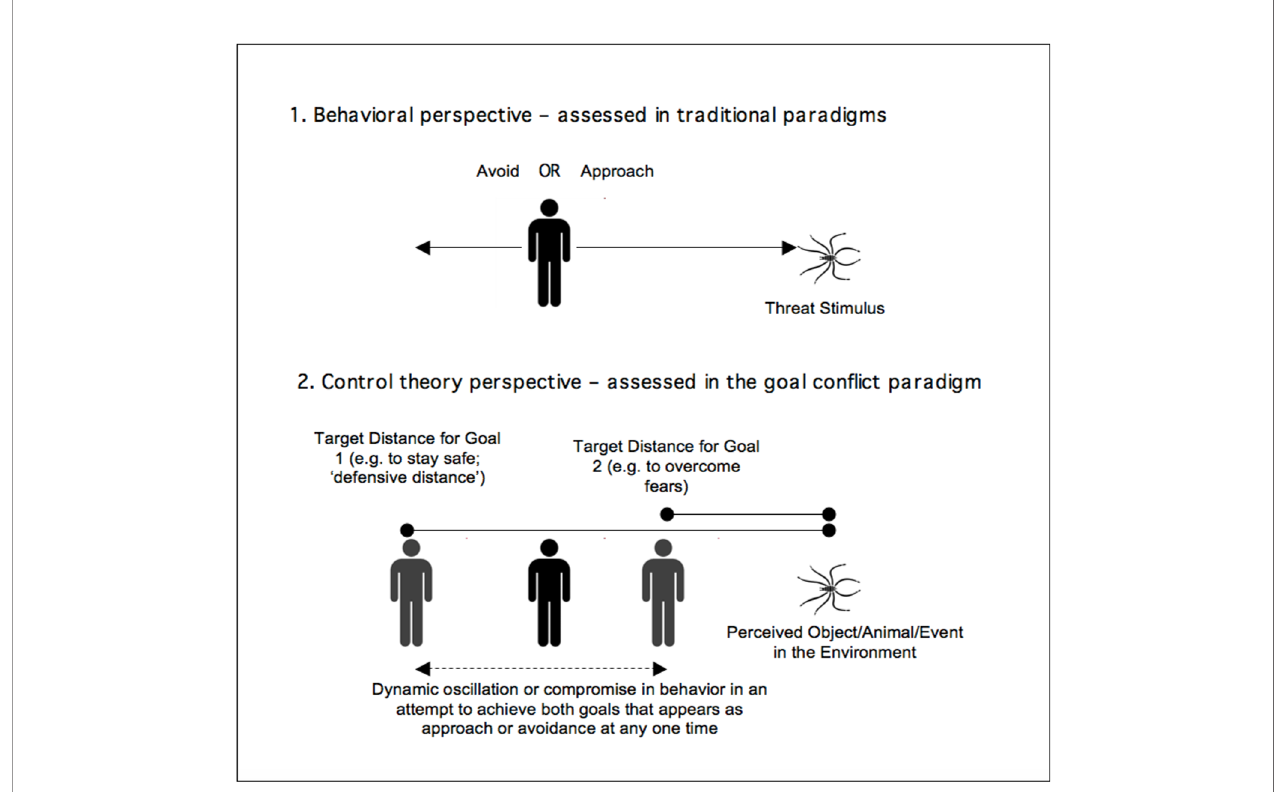
FIGURE 5 | The behavioral perspective on avoidance contrasted with the control theory perspective (79).